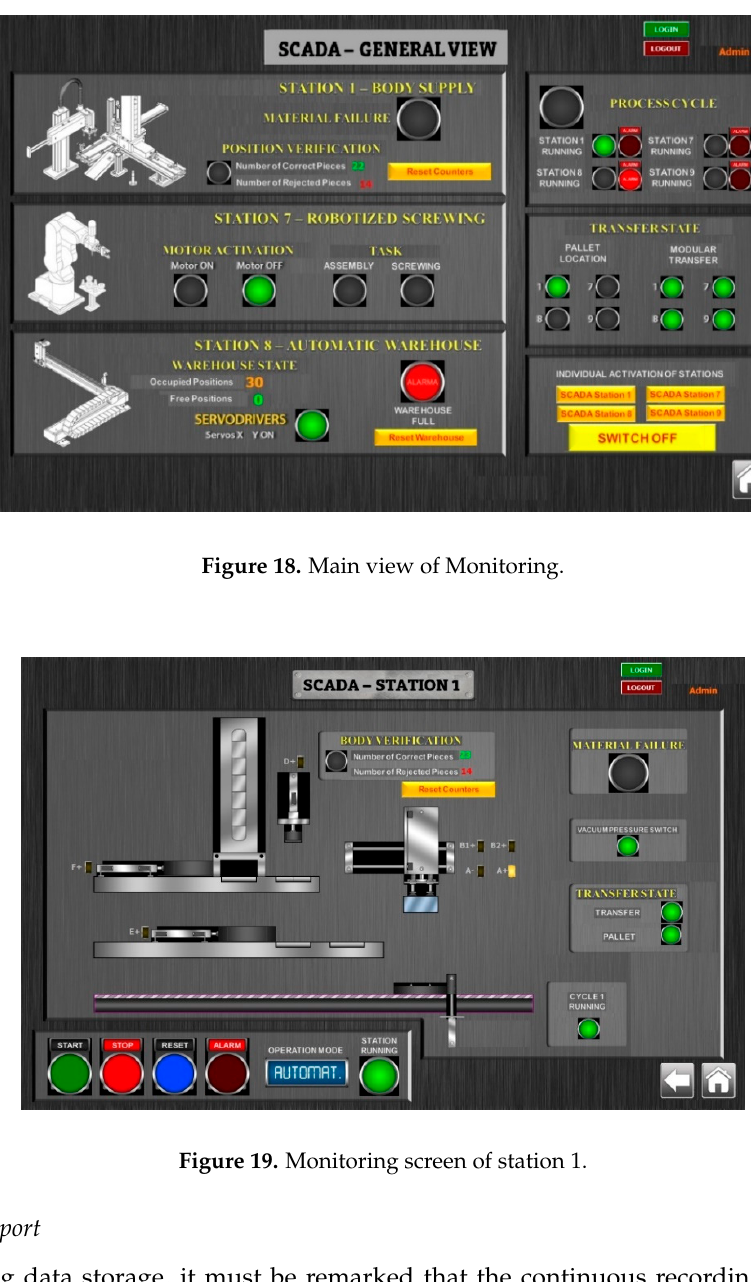
Figure 19. Monitoring screen of station 1.